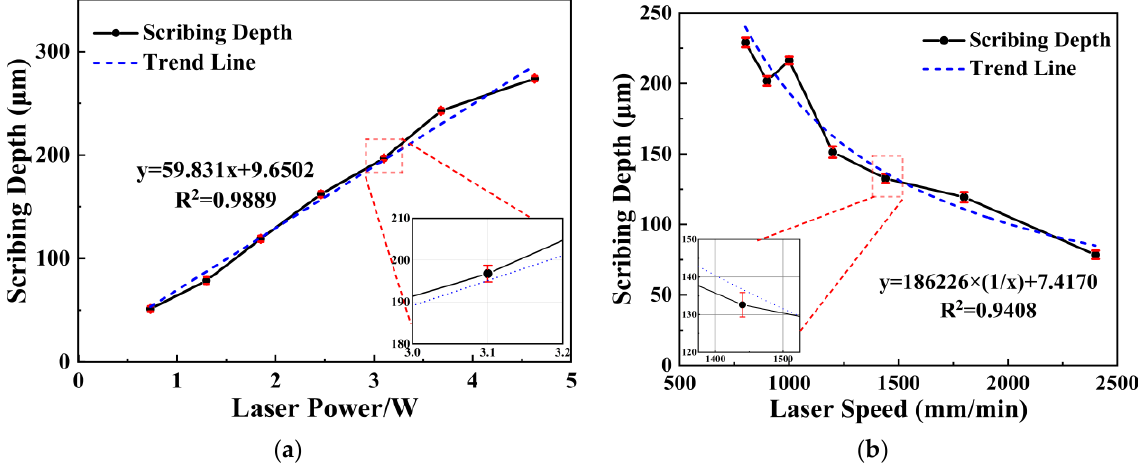
Figure 11. Relationship between laser power and speed with scribing depth. ( a ) Relationship between scribing power and scribing depth; ( b ) Relationship between scribing speed and scribing depth.